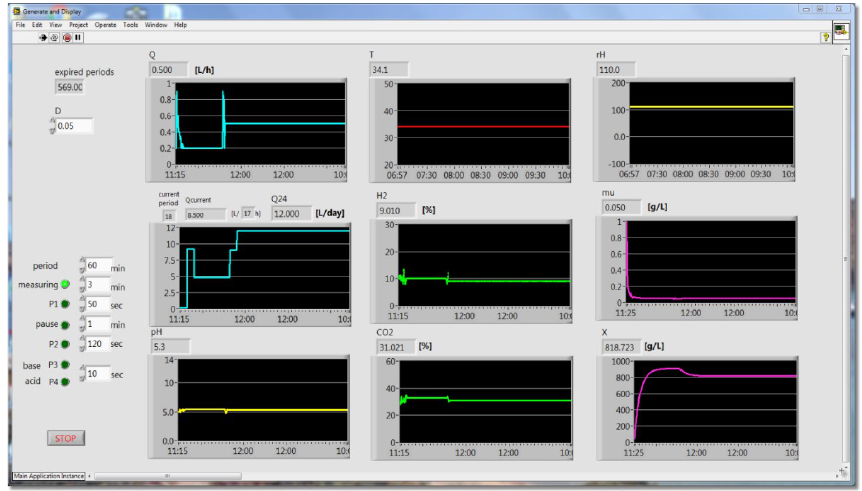
Figure 4. Monitor showing the main measured and calculated values of processes in BR 1